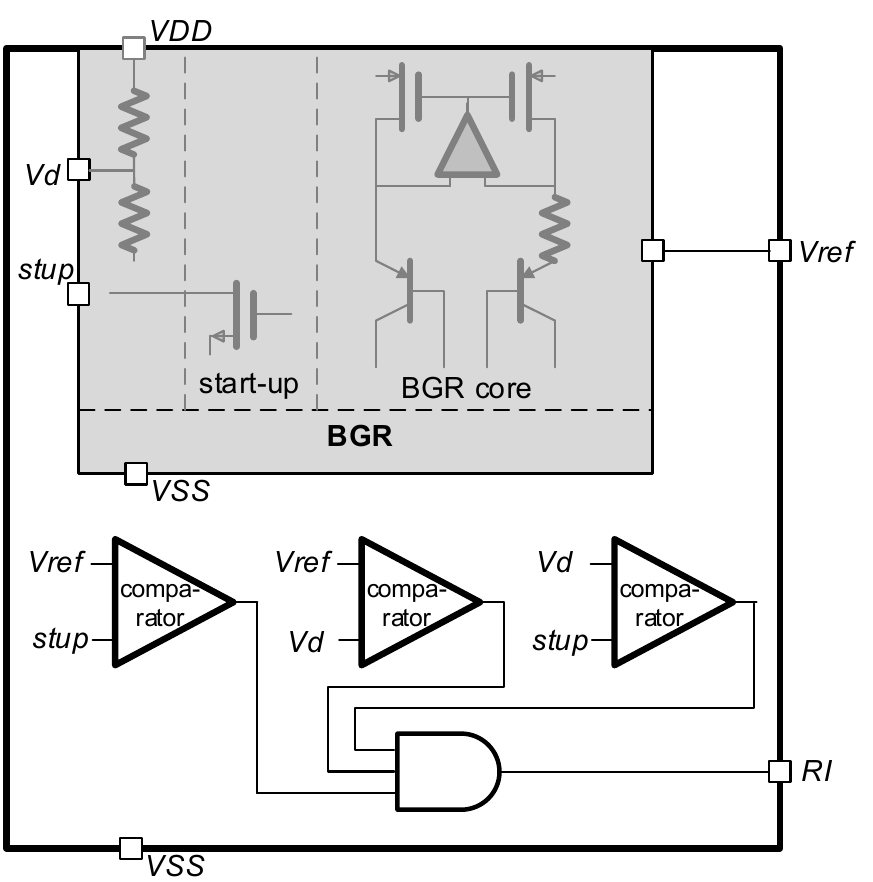
Figure 2. Simplified block diagram of the proposed method.